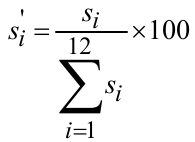
The same price-discount-rate and consumer-trust- index membership functions are used for each